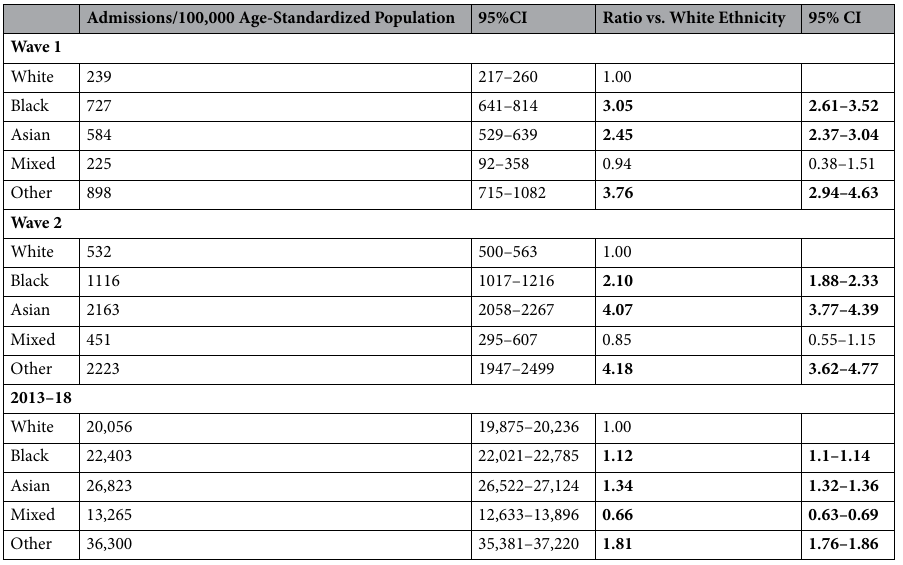
Table 3. Hospital admission rates per 100,000 of the age-standardized local population by ethnic group (based on European standard population for ages 15 to 85 +). Significant values are in